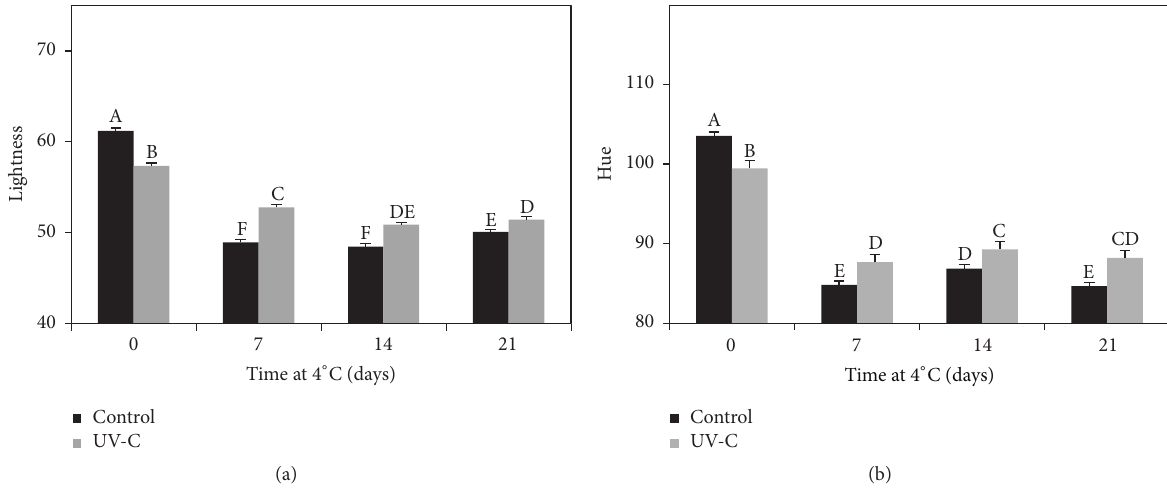
Figure 5: (a) Lightness and (b) hue angle in control and UV-C treated (12.5 kJm −2 ) carambola slices stored for 0, 7, 14, and 21d at 4 ∘ C. Bars represent the standard error ( 𝑛 = 3 ). Different letters indicate significant differences on Fisher’s test ( 𝑃 < 0.05